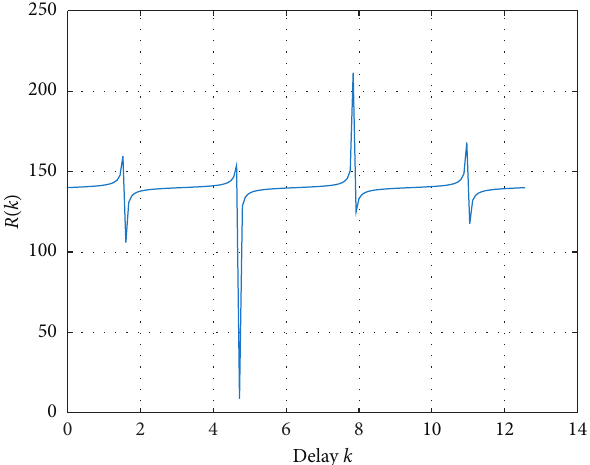
Figure 2: Pitch signal fragment